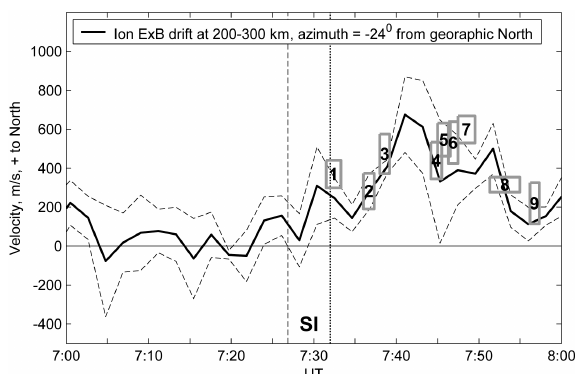
Fig. 7. Velocities of the poleward progression of the auroral forms and the plasma drift measured by the ESR radar between 07:00 UT and 08:00 UT. Vertical dashed and dotted lines indicate the times of the pulse arrival at the bow shock and its detection at the low- latitude magnetic observatory Bangui, respectively. Gray rectangles with numbers show the velocity and its error bar for the auroras indicated in Fig.